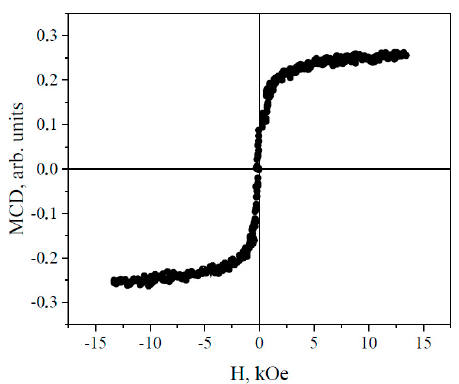
Figure 7. The MCD signal dependence on magnetic field for NiFe 2 O 4 @Au NPs (three-stage coating) recorded at the energy of 2.6 eV.